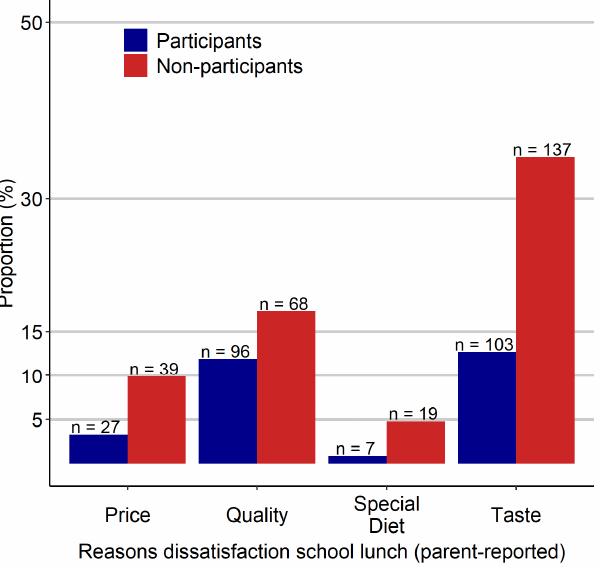
Figure 4. Absolute and relative frequencies of reasons for dissatisfaction with school lunch (parent- reported), stratified by students’ participation. 3.3. Behavioral Differences among Participants and Non-Participants Overall, the most frequent purchases were candy and chips (48.7%; n = 328) and ice cream (42.5%; n = 279) with a seasonal variation in purchasing ice cream (45.6% summer versus 38.4% winter, p = 0.077). Purchasing behavior differed between lunch participants and nonparticipants, particularly for sandwiches and energy drinks (Rates in Table 5). Almost all children (98.0%, n = 1182) brought something from home (lunch box, something to drink, a piece of fruit and/or vegetables) on at least three school days per week, with no significant difference between participants and nonparticipants. However, bringing a piece of fruit and/or vegetables was more frequent in participants than nonpar- ticipants. Table 5. Percentage of students by participation status and different behavior. Pearson chi-squared test was used to com- pare intergroup differences.